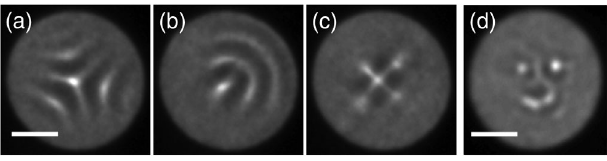
FIG. 4. Programmable electron-beam shaping: detected electron distribution after interaction with shaped light fields. For (a) – (c), the SLM is used to add vertical trefoil, coma, or astigmatism (scale bar 1.1 mm) to the incoming light field. In